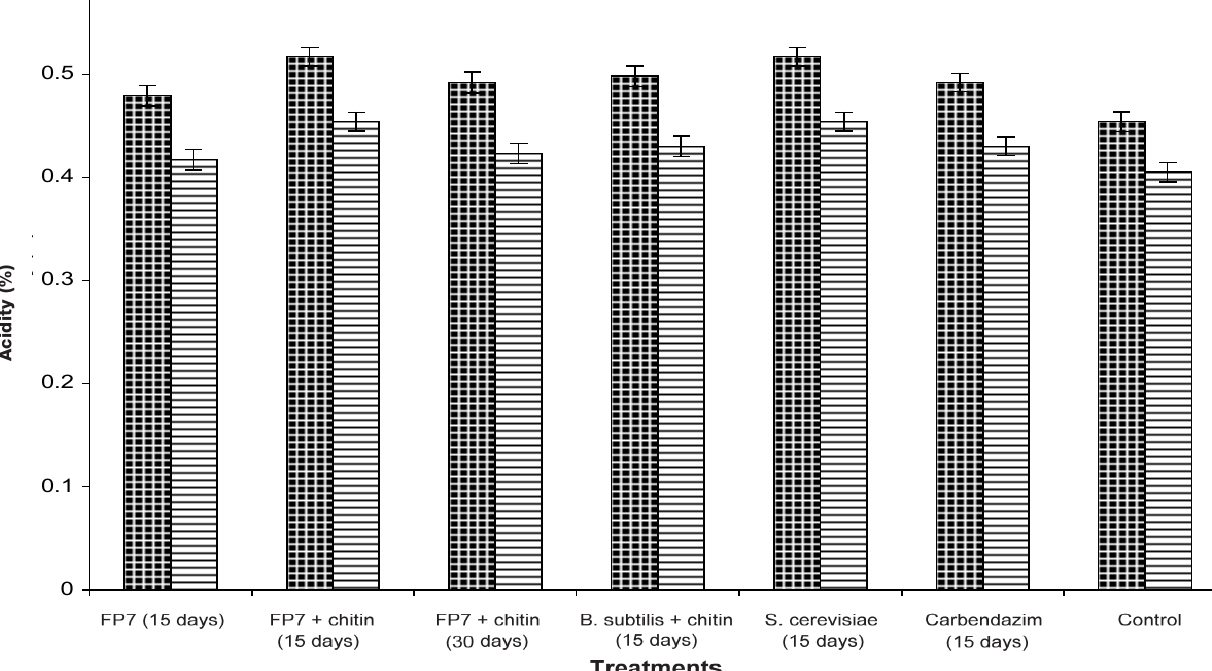
Fig 10. Effect of pre-harvest application of biocontrol formulations on free acidity content in mango